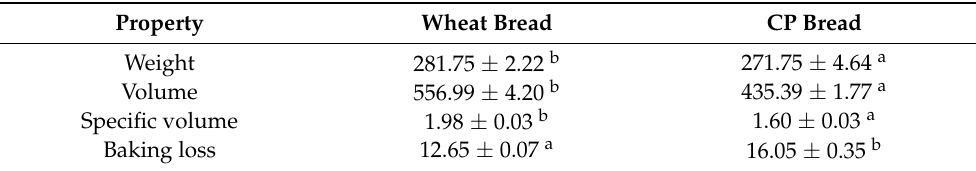
Table 2. Basic characteristics of control wheat bread and wheat bread enriched with 15% carrot pomace (CP).